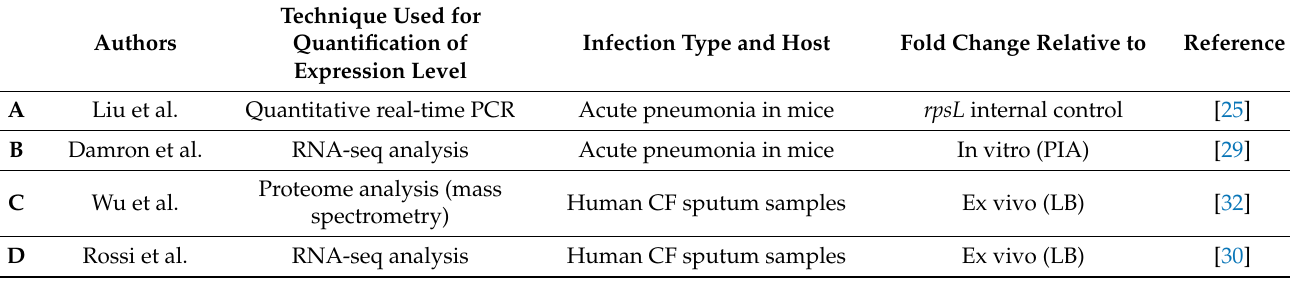
Table 2. Proteomic studies used to assess the expression levels of IAPs of